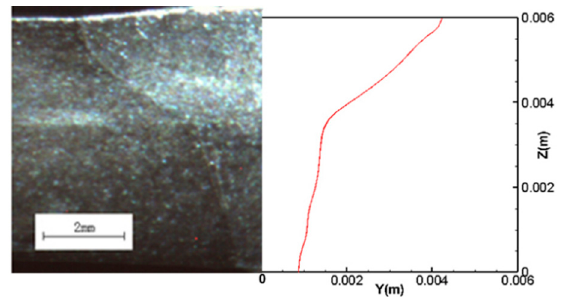
Figure 11. Comparison of captured image and calculated result of weld pool at the transverse cross-section.